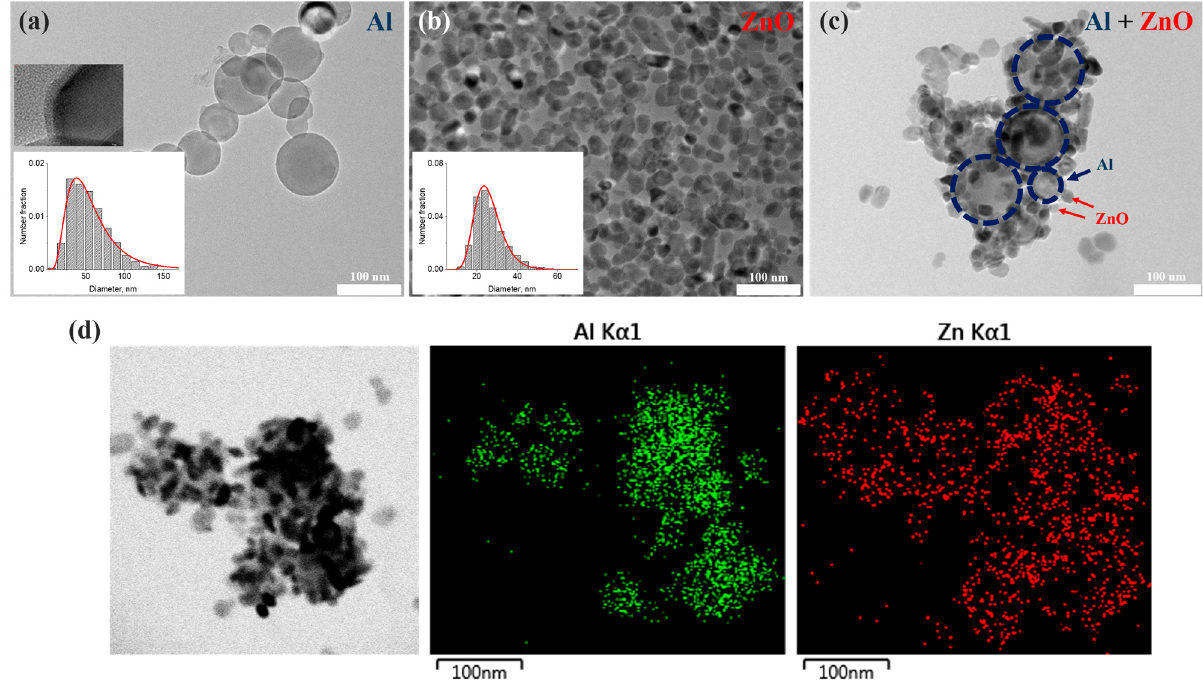
Figure 2. Results of TEM analysis. TEM images of ( a ) metal aluminum, ( b ) zinc oxide nanoparticles and their particle size distributions (inserts), ( c ) an Al-ZnO complex found in the mix colloid of Al 0.0114 g/L + ZnO 0.044 g/L, ( d ) STEM image of an Al-ZnO agglomerate and corresponding EDX elemental map.